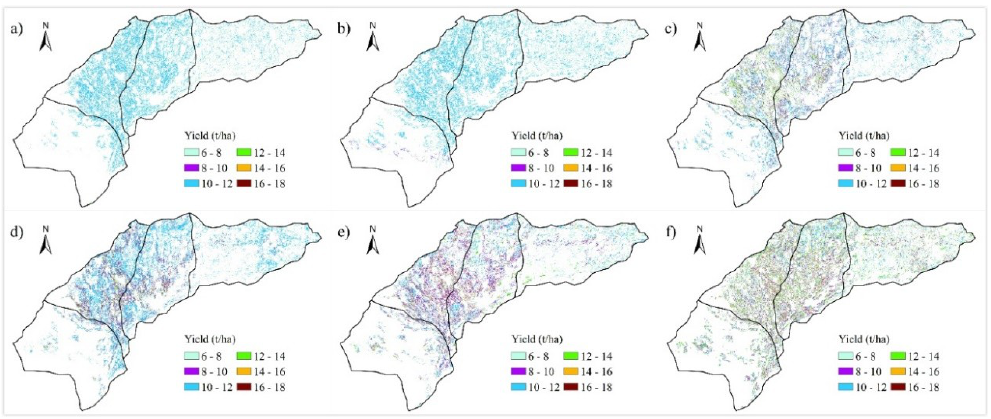
Figure 8. Maize yield maps from 2010 to 2015 ( a – f ).